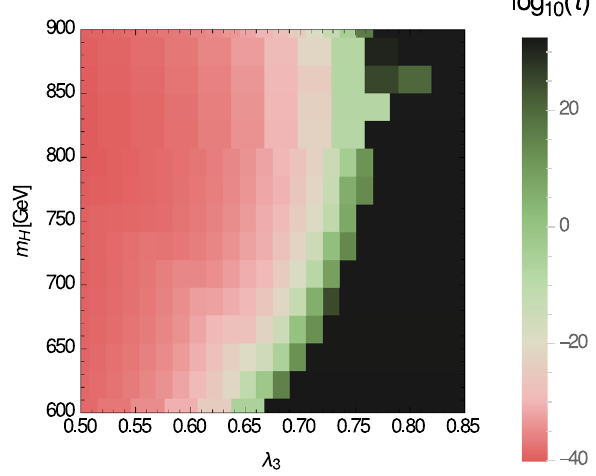
Fig. 13 The scalar potential at the tree-level (left) and one-loop level (right): the colour indicates the difference between the panic mini- mum and the electroweak minimum. The contour lines are constant